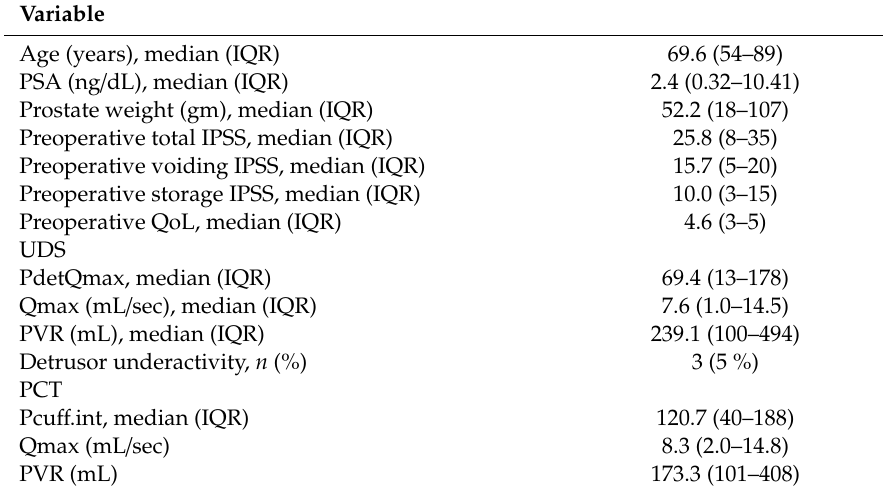
Table 1. Patients’ preoperative demographic data (59